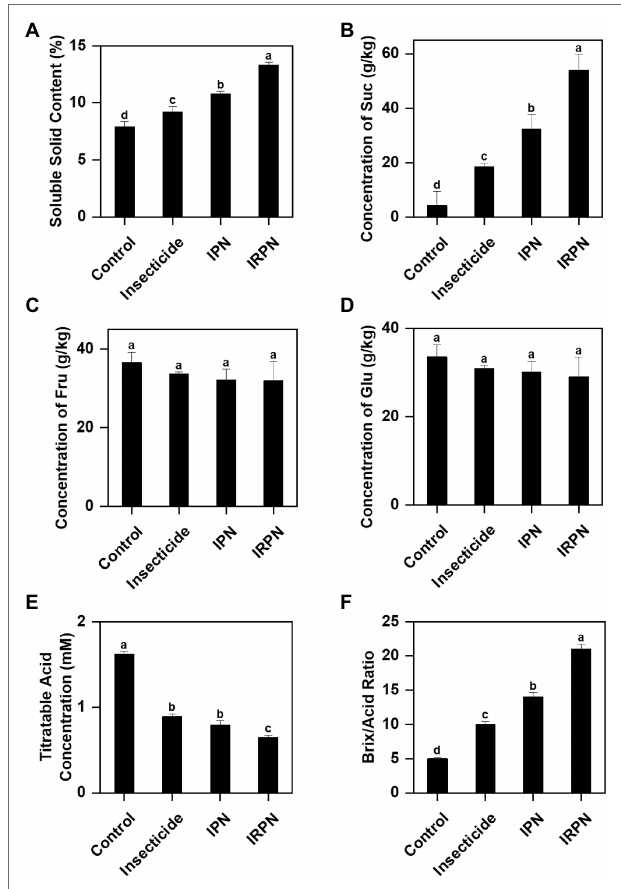
FIGURE 3 | Contents of sugars and organic acids in Chinese bayberry grown under different conditions. Soluble solid content (%) (A) , sucrose (g/kg) (B) , fructose (g/kg) (C) , glucose (g/kg) (D) , titratable acid (mM) (E) and the Brix/Acid ratio (F) were analysed for fruit juice of Chinese bayberry collected from trees grown under natural conditions (controls) or treated separately with insecticides, IPNs or